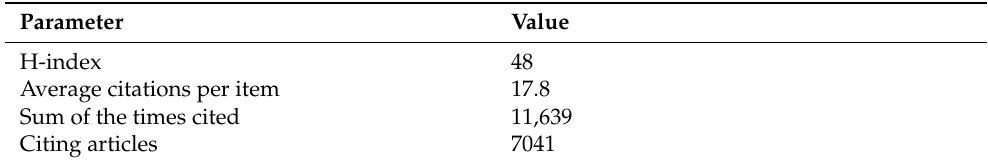
Table 2. Bibliometric parameters refer to the studied